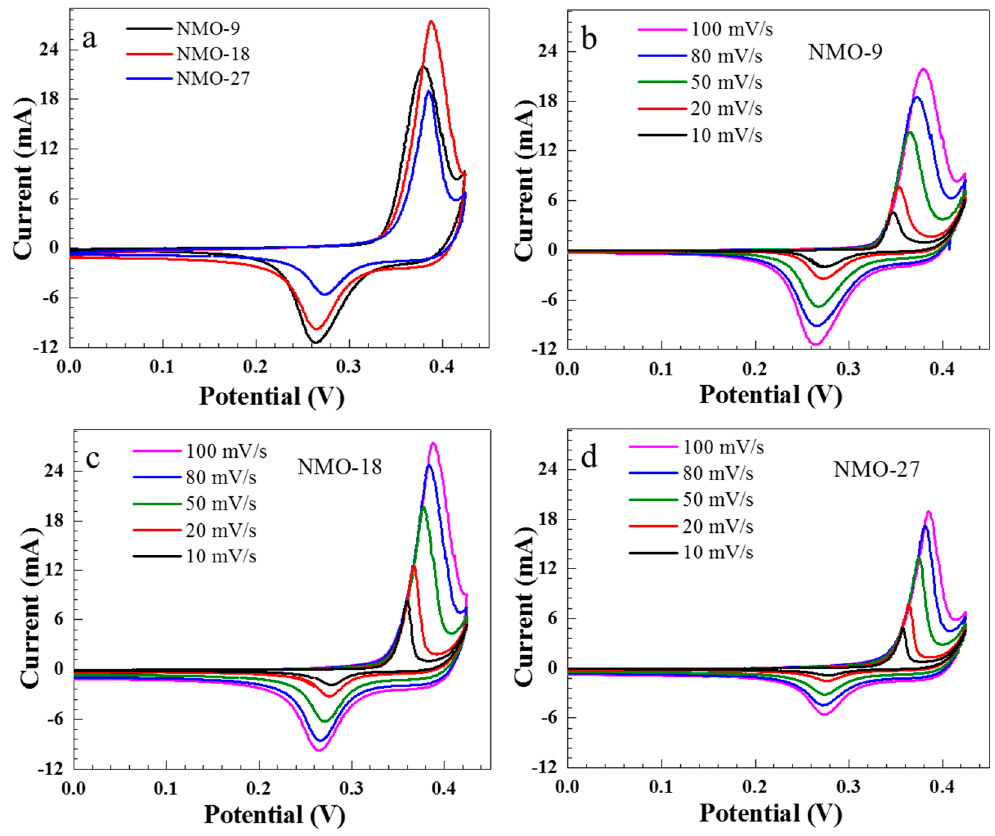
Figure 3. Cyclic voltammograms (CVs) for ( a ) NMO-9, NMO-18, and NMO-27 samples at 100 mV/s scan rate and various scan rates for ( b ) NMO-9; ( c ) NMO-18; and ( d ) NMO-27.